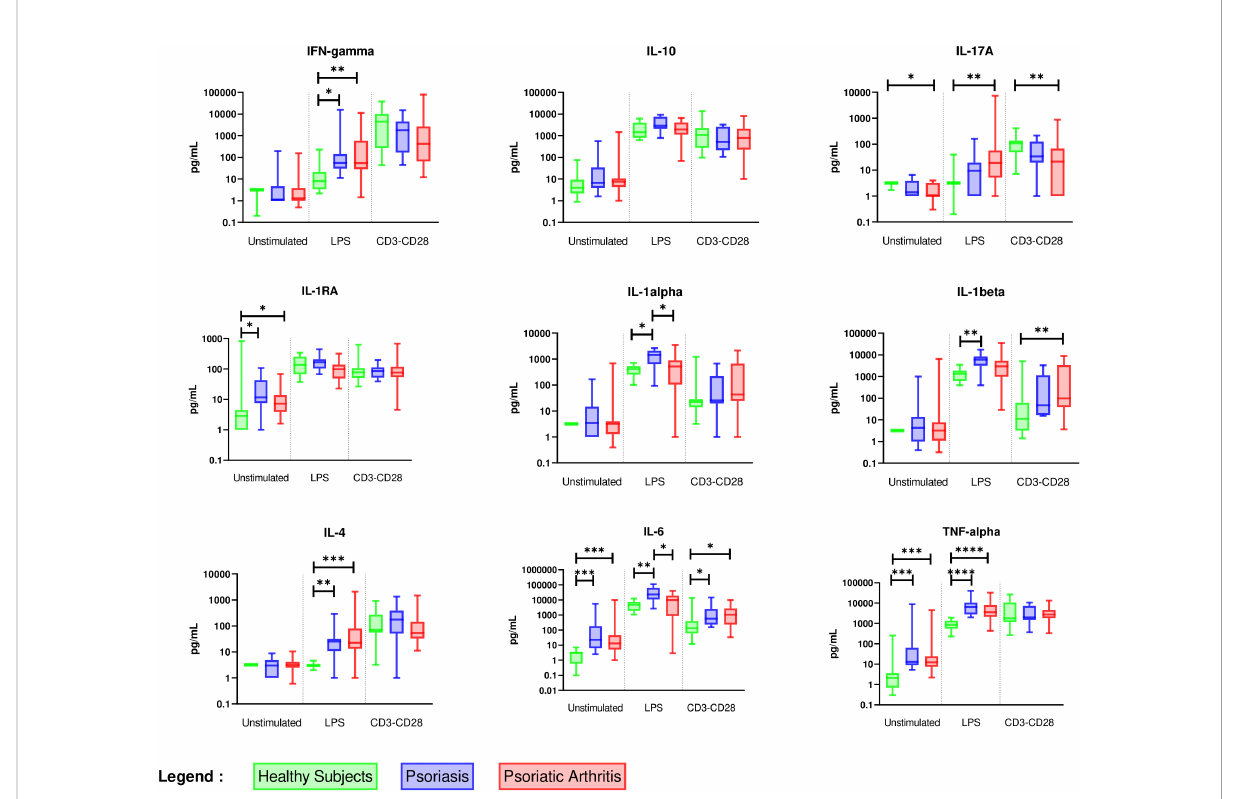
FIGURE 3 Overall comparison of ex vivo cytokine production between healthy subjects (n = 11), PsO (n = 11), and PsA (n = 37) patients. PBMCs from healthy subjects (n = 11), PsO (n = 11), and PsA (n = 37) patients were cultured at 1x10 6 cells/ml for 24 h at 37°C, 5% CO 2 with and without stimulation of monocytes by E. coli LPS (1 µg/mL) or T lymphocytes by anti-CD3/CD28 mAb (2.5 × 10 4 beads/10 6 cells/ml). Supernatants were collected and cytokine levels were assayed by Luminex Multiplex ELISA. Results are presented using median values with minimum to maximum box-plot. Difference between the groups using non- parametric Kruskal-Wallis test with Dunn ’ s multiple comparison test is presented at the top of the fi gure for each condition. * p < 0.05; ** p < 0.01; *** p < 0.001; **** p <